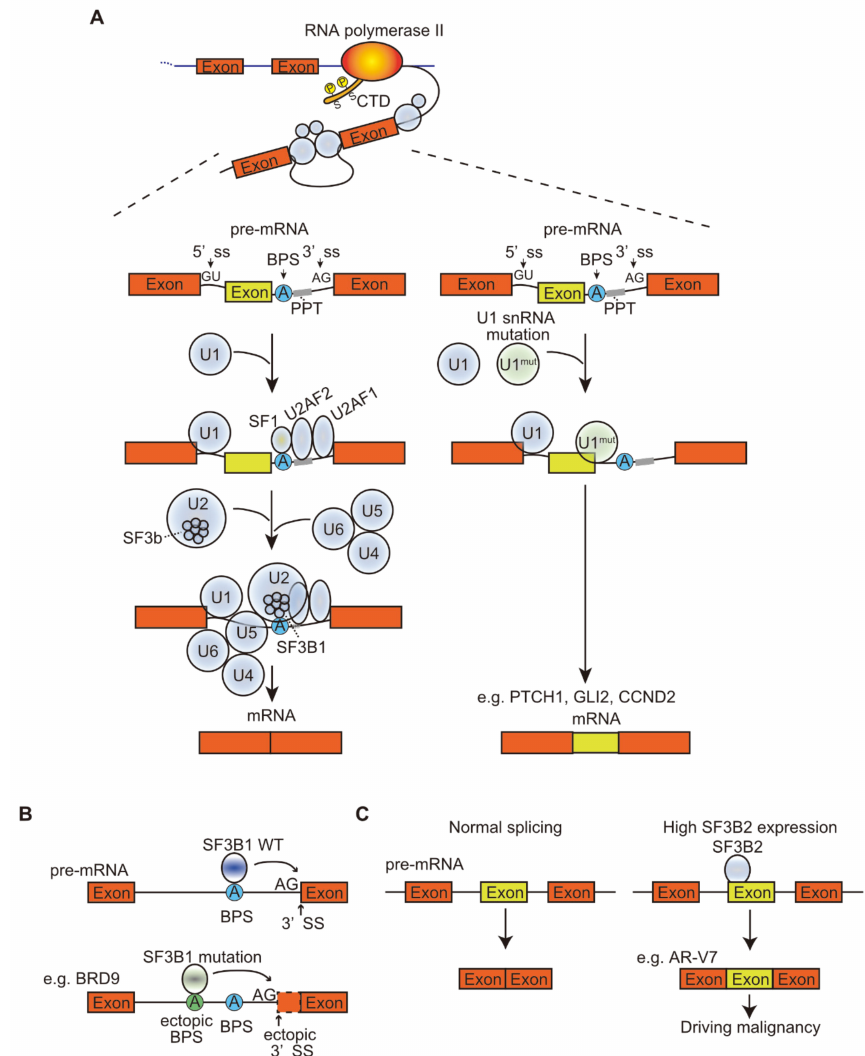
Figure 1. Splicing is dysregulated by mutations in snRNA and splicing factors and expression levels of splicing factors. Splicing is a catalytical process that removes introns from precursor mRNA (pre-mRNA) to generate mature mRNA and is caused by dynamic changes in large protein-RNA complexes called spliceosomes. pre-mRNA is processed by the spliceosome in conjunction with transcription regulating factors. ( A ) The pre-mRNA is transcribed by RNA polymerase II (RNAPII) and spliced by spliceosomes. In the major spliceosomes, U1 and U2 small nuclear ribonucleoproteins (snRNPs) have a pivotal role to recognize 5 (cid:48) and 3 (cid:48) splice sites (ss). These complexes recognize functional intron sequences such as 5 (cid:48) and 3 (cid:48) ss, the branch point site (BPS), and the polypyrimidine tract (PPT). The U1 snRNP binds to the 5 (cid:48) ss on the pre-mRNA and the U2 snRNP binds to the BPS with the aid of the U2 auxiliary factor (U2AF). This splicing machinery in association with other proteins removes the intron with a lariat structure from pre-mRNA to generate the mature mRNA. The mutation in U1 snRNA modifies the RNA recognition sequence of U1 snRNP, allowing the mutated U1 snRNP to bind to the 5 (cid:48) ss of cryptic exon, which results in the inclusion of the cryptic exon. ( B ) SF3B1 is a critical factor to bind the SF3b complex to the BPS sequence in the intron. A mutation in SF3B1 modifies the RNA recognition sequence, allowing mutated SF3B1-binding to an ectopic BPS. The mis-binding shifts the position of the 3 (cid:48) ss upstream, resulting in ectopic 3 (cid:48) ss. ( C ) Expression levels of splicing factors are also involved in the regulation of splicing. SF3B2 is a component of the SF3b complex that is ubiquitously expressed. High SF3B2 expression promotes splicing in the target exons and introns, resulting in increased cancer malignancy-driving splicing variants, such as